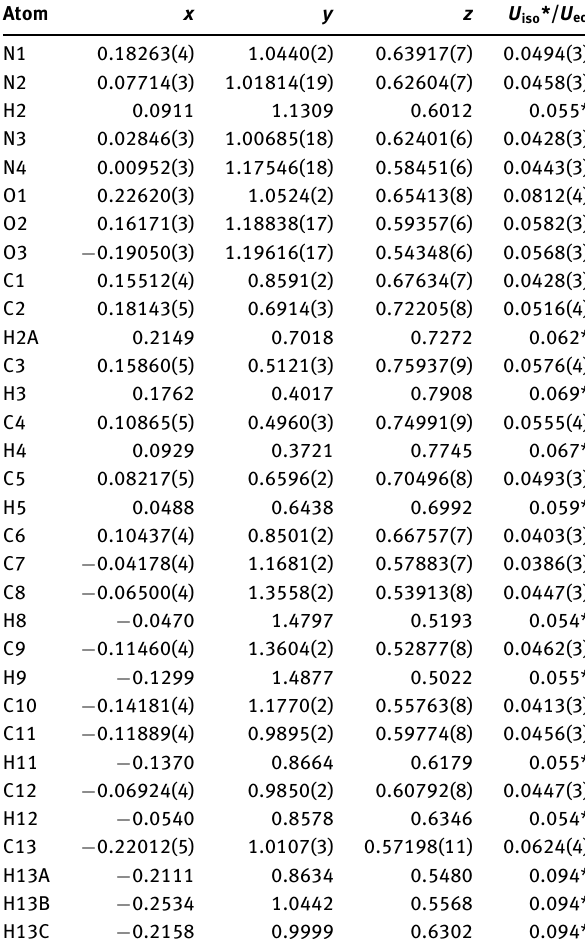
Table 2: Fractional atomic coordinates and isotropic or equivalent isotropic displacement parameters (Å 2